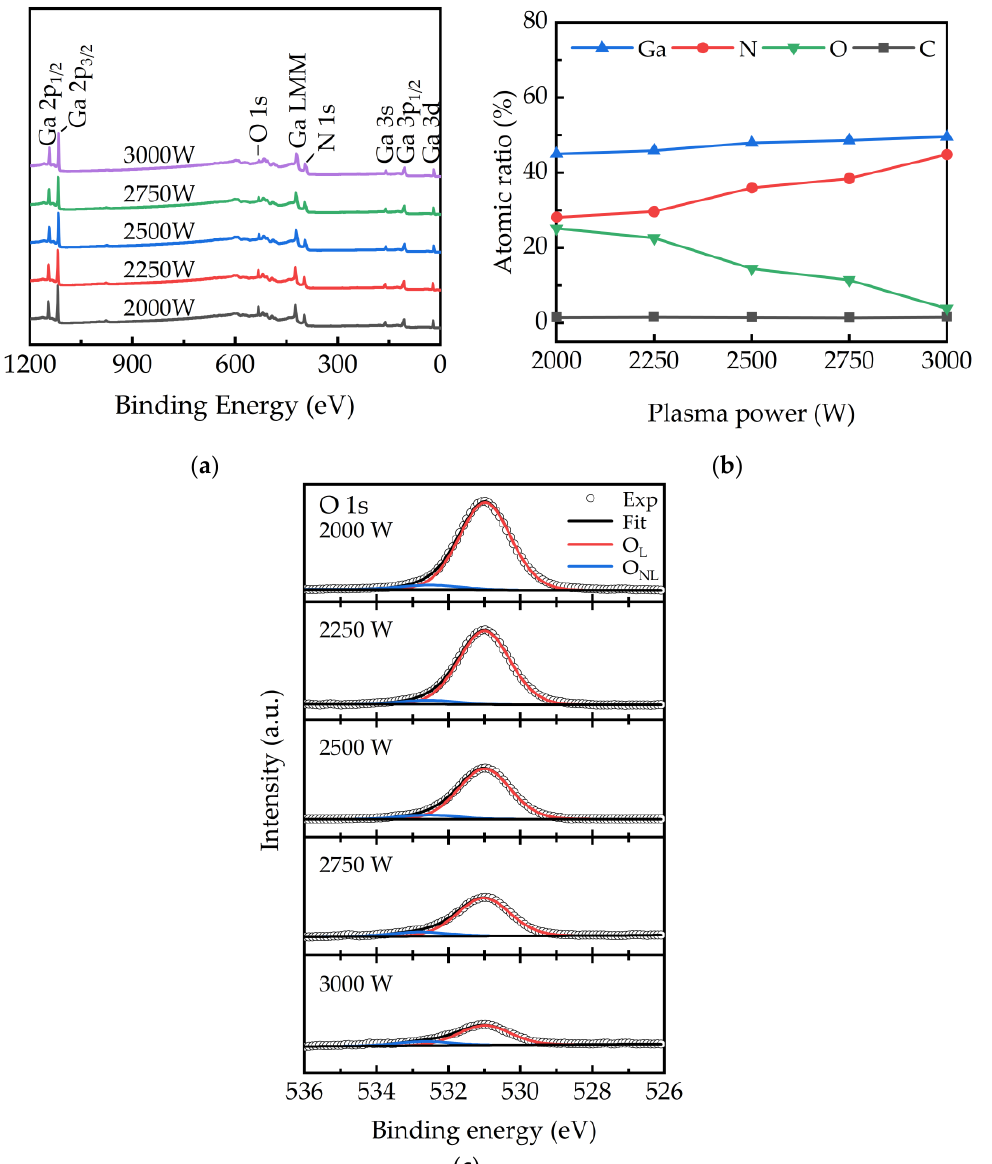
Figure 3. ( a ) The survey spectra, ( b ) the concentration, and ( c ) the O1s detail scan of GaN films obtained at different plasma power.